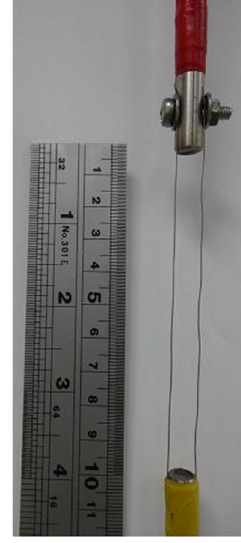
Fig. 3. The developed suspension wire.